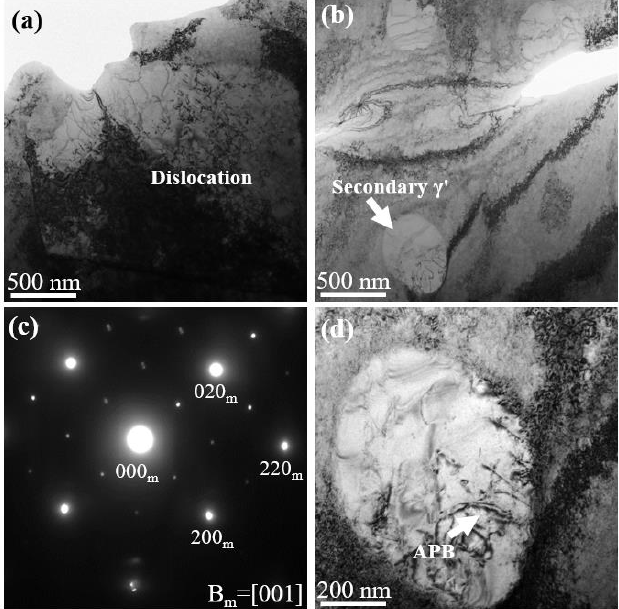
Figure 4. Deformed microstructure of the room temperature-tested sample: ( a , b ) high-density dislocations in γ matrix and γ′ precipitates, ( c ) SAED pattern, ( d ) APB in the secondary γ′ precipitates.